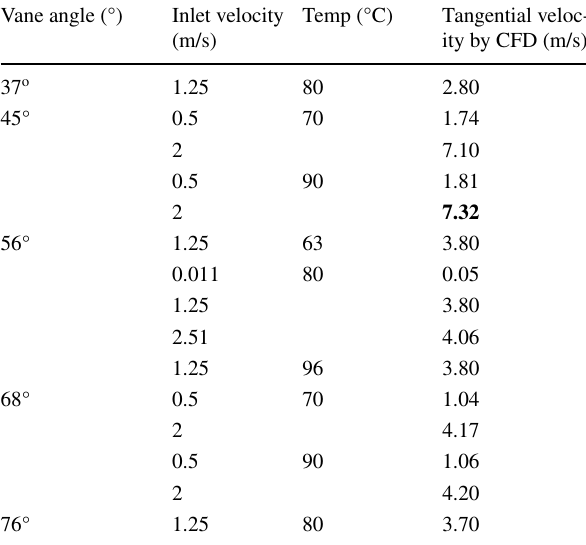
Table 3 CFD prediction of exit velocity from the vanes for various combinations of DOE variables Vane angle (°) Inlet velocity (m/s)